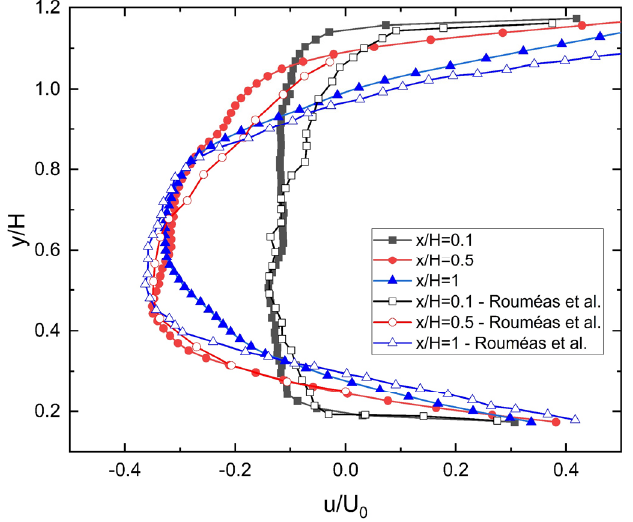
Figure 10. Vertical normalized streamwise velocity profiles, determined at different x/H positions in the symmetry plane.